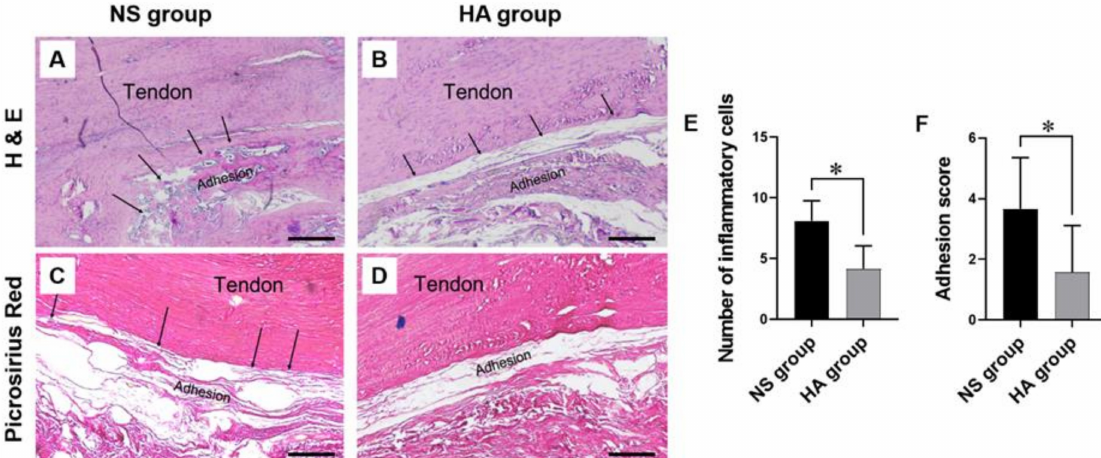
Figure 2. Representative images and analysis of H&E and picrosirius red staining at 10 weeks after surgery. ( A , C ) H&E and picrosirius red staining in the normal saline (NS) control group: there is obvious adhesion with moderate density between the repaired tendon and the surrounding soft tissue. The adhesion fibers (arrow) connecting soft tissue to the tendon surface are observed. Scale bar = 100 µ m. ( B , D ) H&E and picrosirius red staining in the hyaluronic acid (HA) group: a few loose adhesions are observed between the repaired tendon and the sheath, and peritendinous adhesions are mild. The adhesion fibers connecting the subcutaneous tissue and the tendon surface are not observed. Scale bar = 100 µ m. ( E ) The mean numbers of inflammatory cells in three serial high-power fields are 8.13 ± 1.65 in the NS control group, and 4.17 ± 1.90 in the HA group (* p < 0.05). ( n = 12 for each group). ( F ) The adhesion score is significantly lower in the HA group (1.58 ± 1.52) than in the control group (3.66 ± 1.68) (* p < 0.05). Values represent the means ± standard error of the mean (SEM). ( n = 12 for each group).